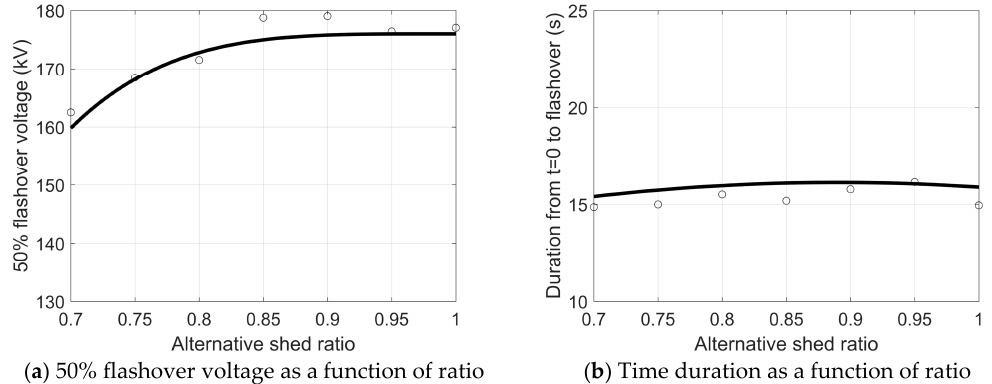
Figure 18. 50% flashover voltage and time duration as functions of the alternative shed ratio.